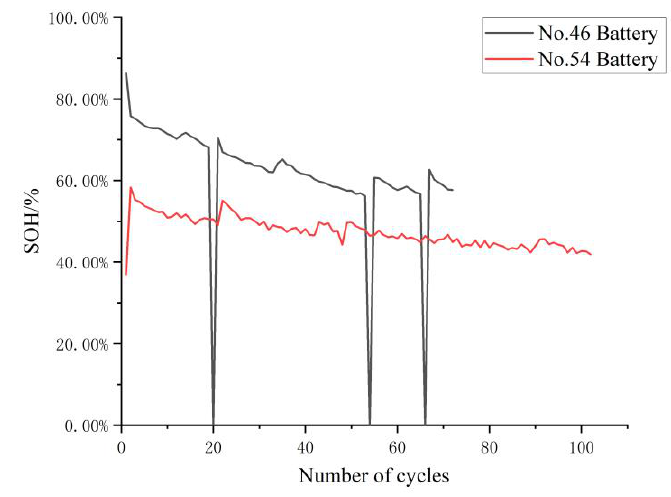
Figure 2. Change curve of SOH at different discharge rates.